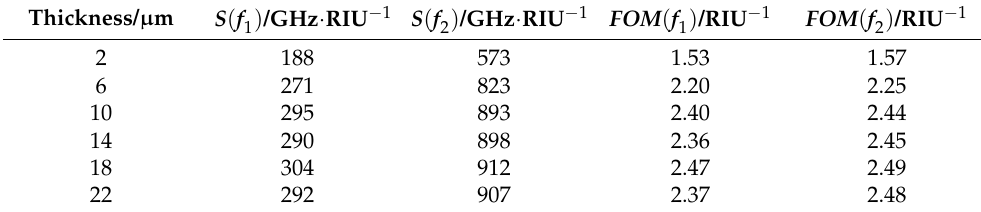
Table 1. Performance of the proposed THz MM sensor with different analyte